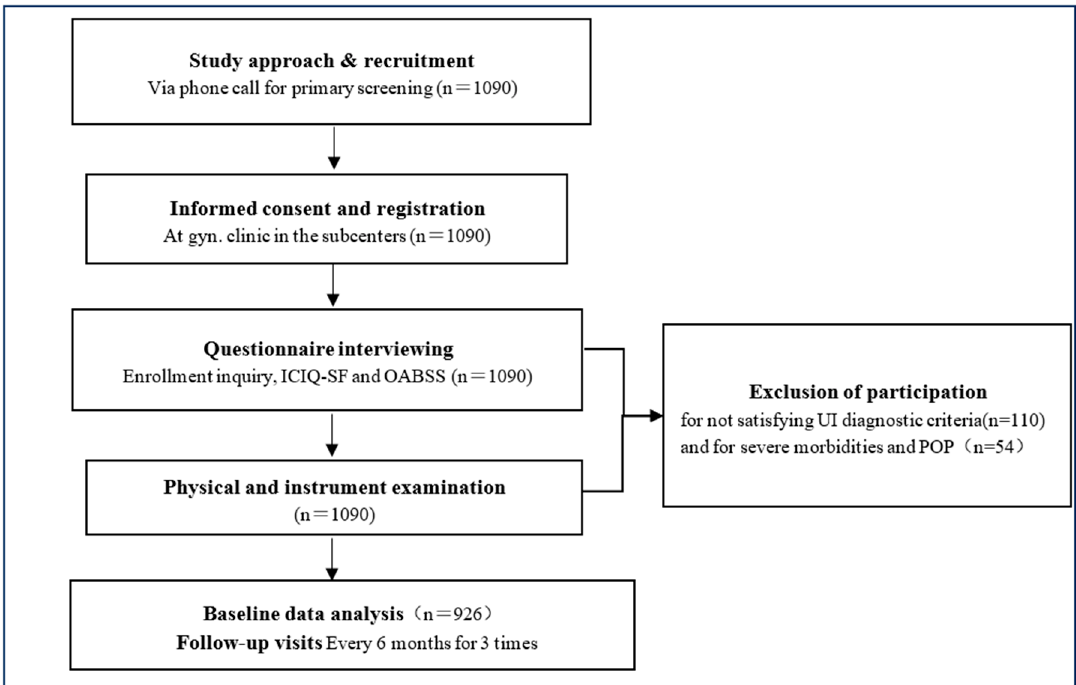
Figure 1. Flow chart for participation.